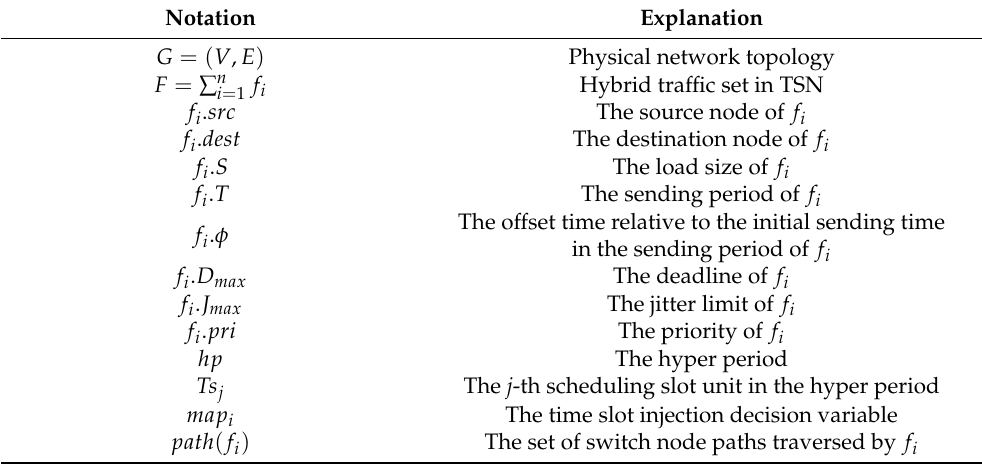
Table 1. The main notations used in the system model and problem description.